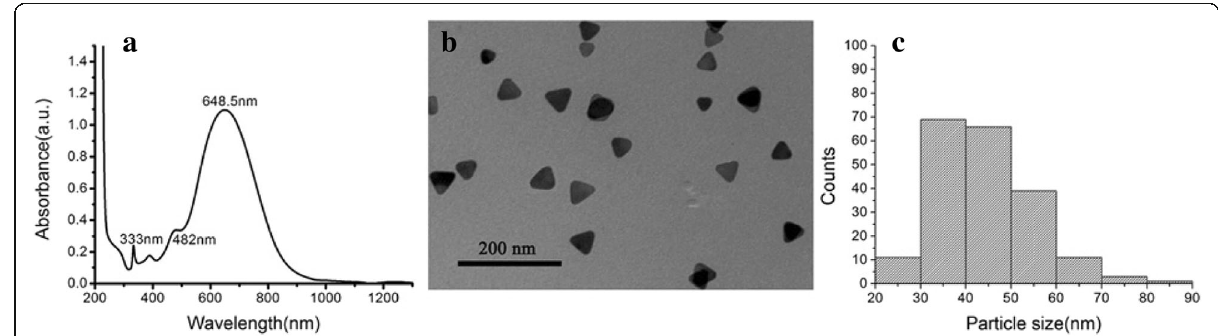
Fig. 1 Characterization of the triangular silver nanoplates. a UV-vis spectrum of the prepared solution. b TEM image of the gathered silver nanoparticles after centrifugation. c Size distribution of the selected triangular silver nanoplates (200 nanoparticles from TEM